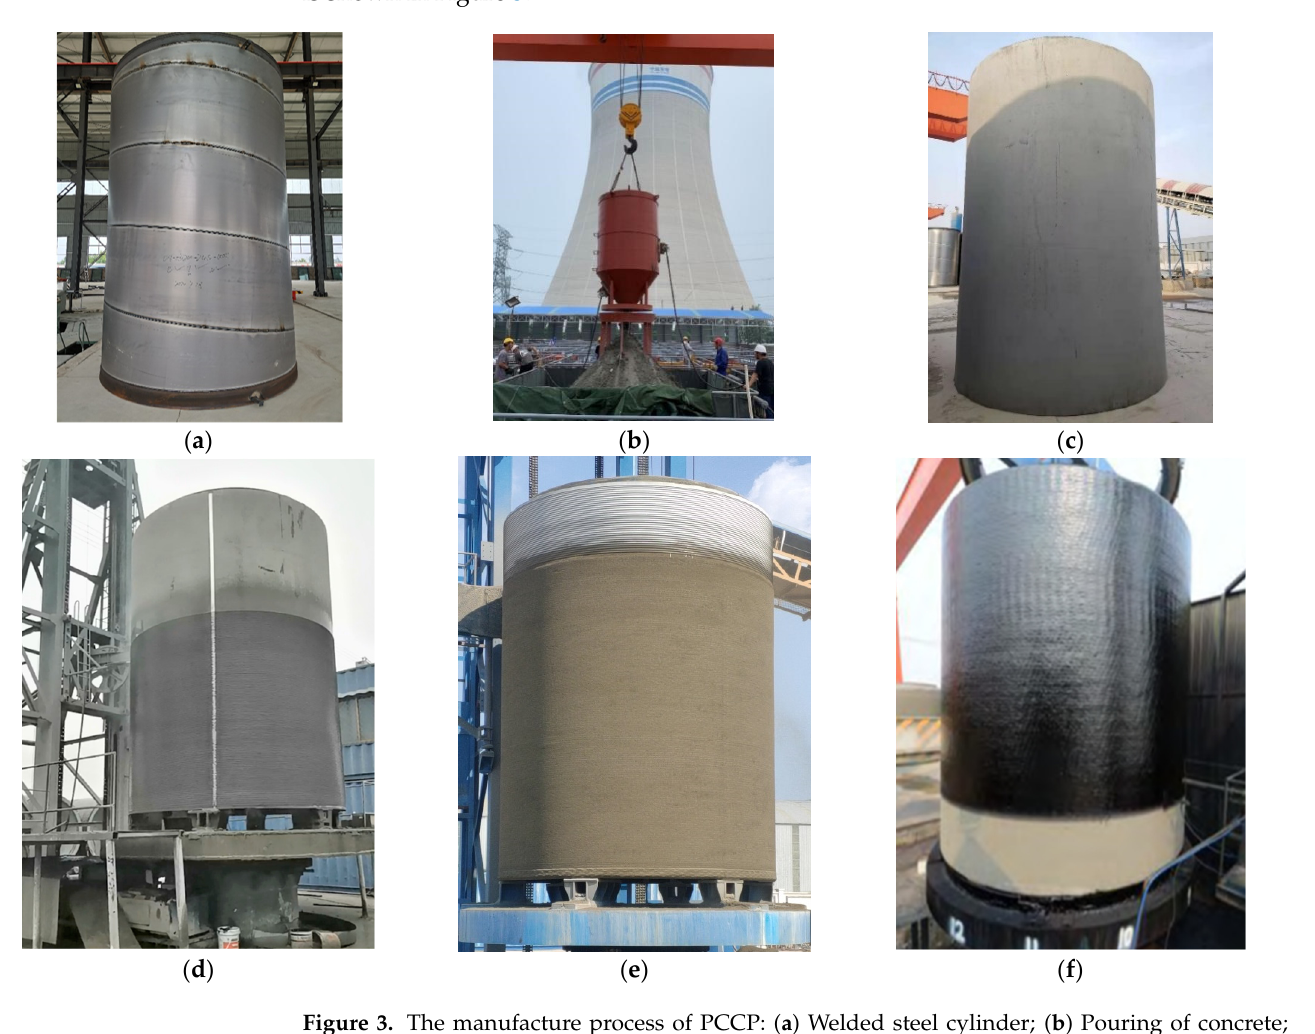
Figure 3. The manufacture process of PCCP: ( a ) Welded steel cylinder; ( b ) Pouring of concrete; ( c ) Concrete core; ( d ) Wrapping of prestressed steel wire; ( e ) Roll shooting of protective mortar; ( f ) Anti-corrosion coating.